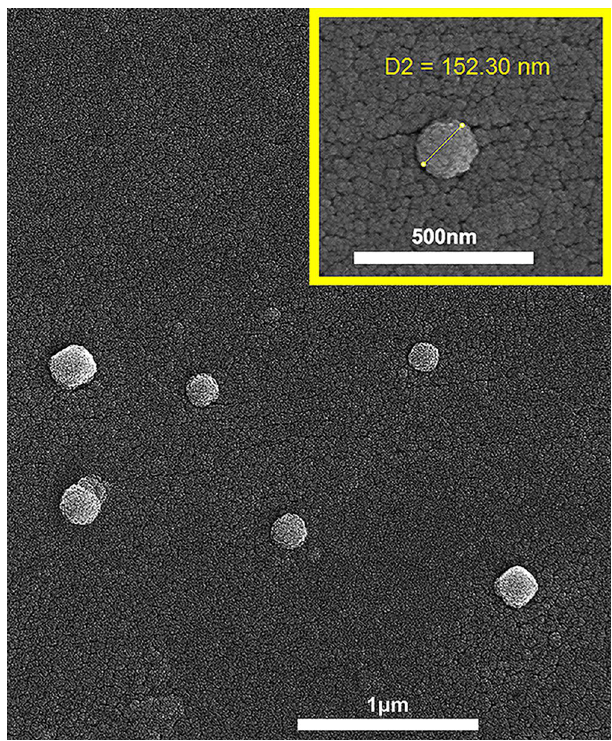
Figure 3. SEM image of PLA-PEG-Apt/DOX NPs (at w/w ratio 10:1).